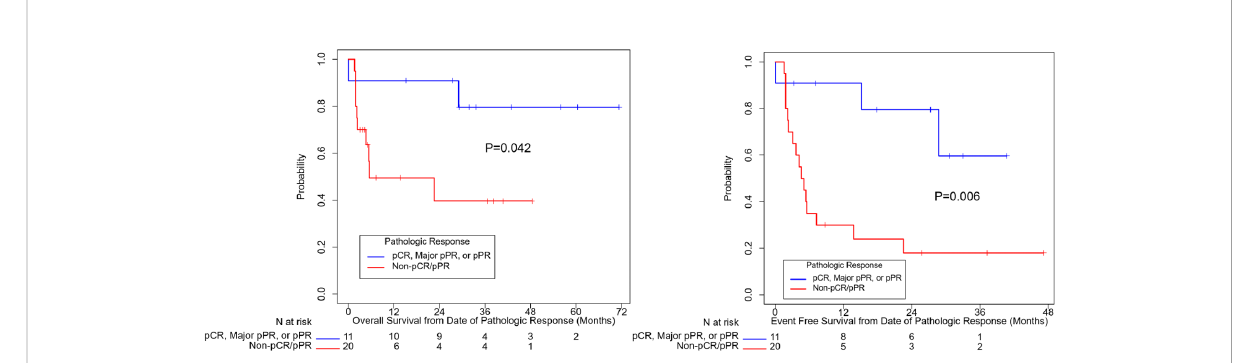
FIGURE 2 Overall survival and event free survival strati fi ed based on pathologic response per INMC criteria. pCR, pathologic complete response; pPR, pathologic partial response.